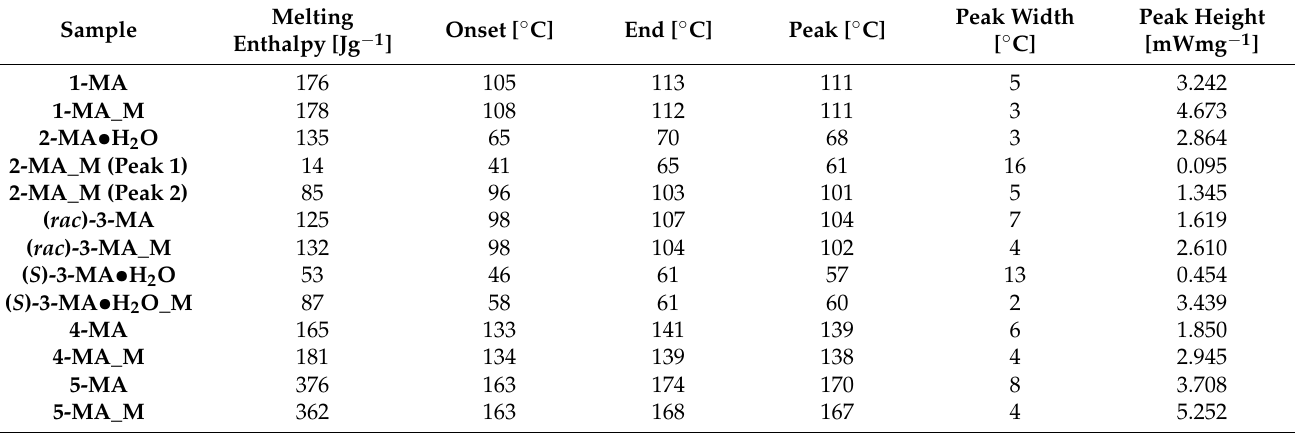
Table 2. Overview of the recorded DSC parameters for all investigated samples. Temperature values have been rounded to full